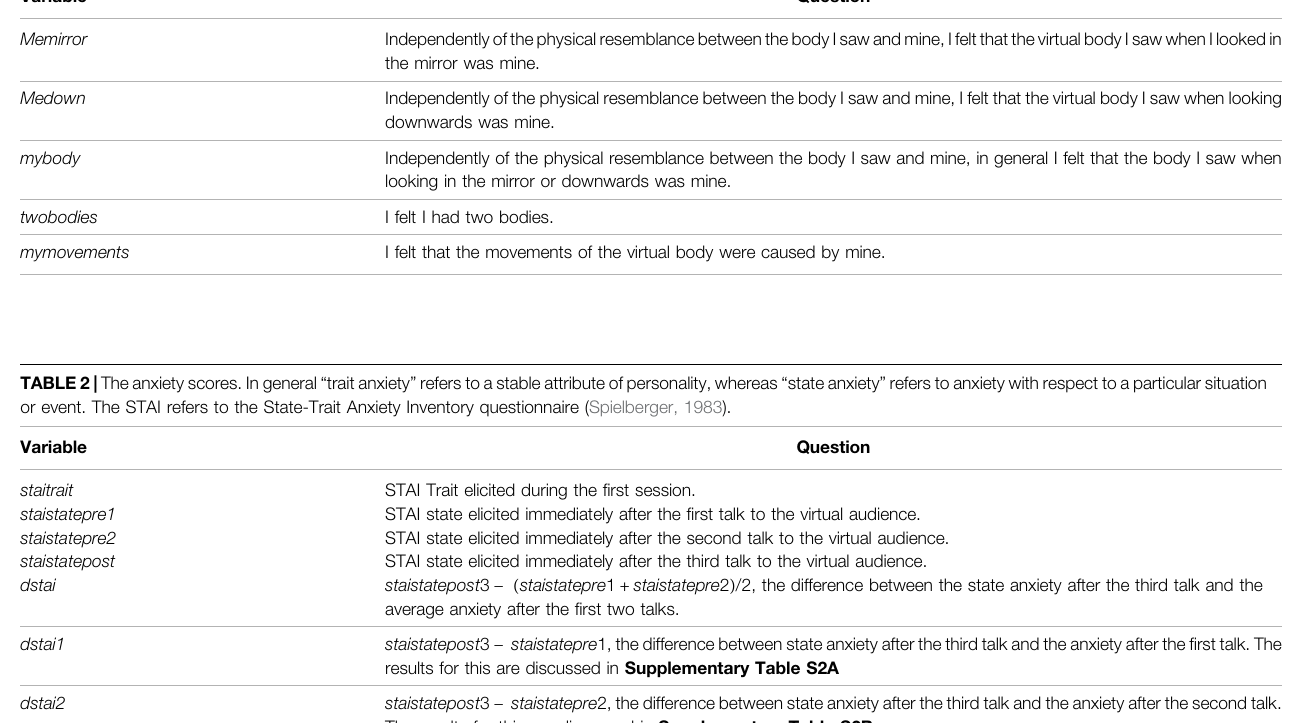
TABLE 1 | Subjective evaluation of the body ownership illusion. The questionnaire was answered after completing each talk. Answers were rated on a 7-point Likert scale, where 1 was “ Not at all ” and 7 was “ Completely ” . Variable